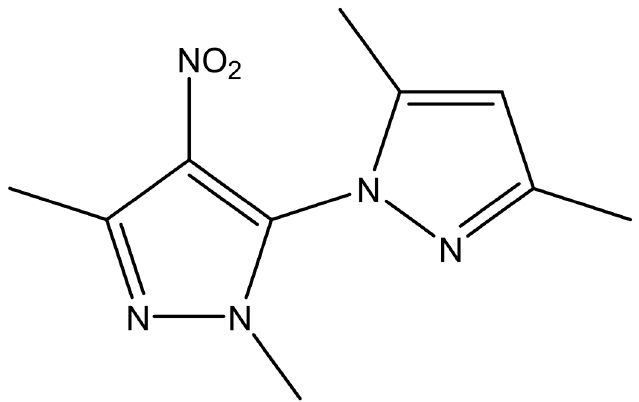
(cid:48) ,3,3,5 (cid:48) -Tetramethyl-4 (cid:48) -nitro-2 (cid:48) H-1,3 (cid:48) -bipyrazole (TMNB) chemical Figure 1. 2 ′ ,3,3,5 ′ -Tetramethyl-4 ′ -nitro-2 ′ H-1,3 ′ -bipyrazole (TMNB) chemical structure. Figure 1. 2